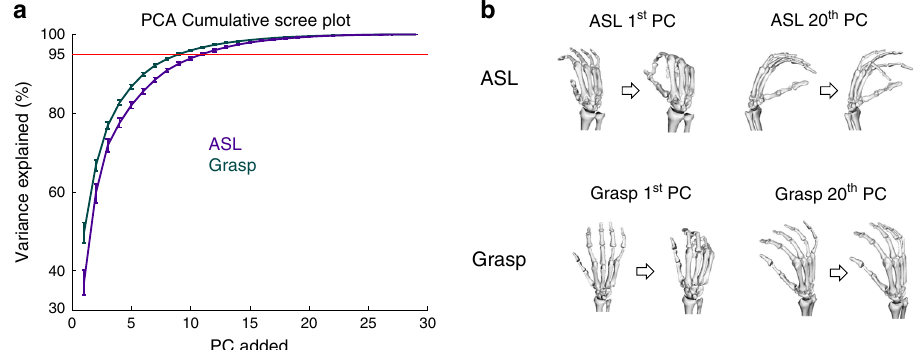
Fig. 3 Principal components analysis. a Cumulative percentage of variance explained vs. number of principal components. PCA is performed separately for each task and subject. The curves are averaged across eight subjects for grasp and across three subjects for ASL. Error bars denote the standard error of the mean. b Visualization of example PCs. For each task, we show the 1st and the 20th PCs (in terms of variance explained). The 20th PC accounts for less than one percent of the